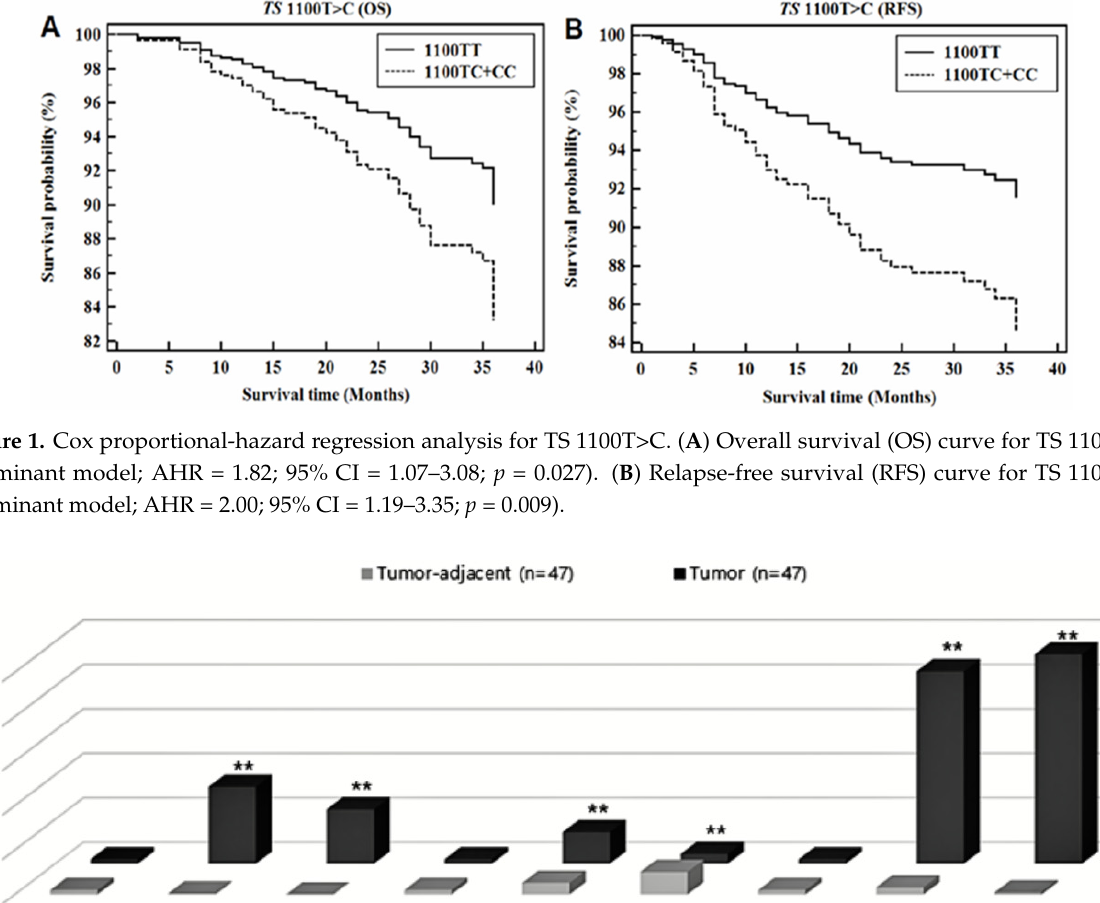
Figure 1. Cox proportional-hazard regression analysis for TS 1100T>C. ( A ) Overall survival (OS) curve for TS 1100T>C (Dominant model; AHR = 1.82; 95% CI = 1.07–3.08; p = 0.027). ( B ) Relapse-free survival (RFS) curve for TS 1100T>C (Dominant model; AHR = 2.00; CI = 1.19–3.35; p = 0.009).